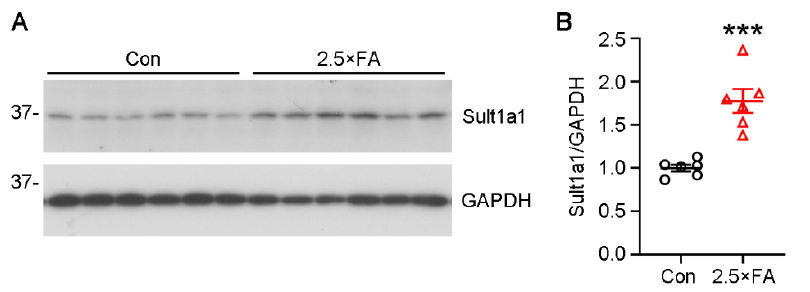
Figure 7. The protein levels of Sult1a1 were elevated in 2.5 × FA brains at P21d. ( A ) The brains of control and 2.5 × FA mice were lysed and analyzed by Western blots, comparing anti-Sult1a1 levels ( n = 6). GAPDH was used as a loading control. ( B ) The protein levels of Sult1a1 were calculated by normalizing to GAPDH. ***, p < 0.001.